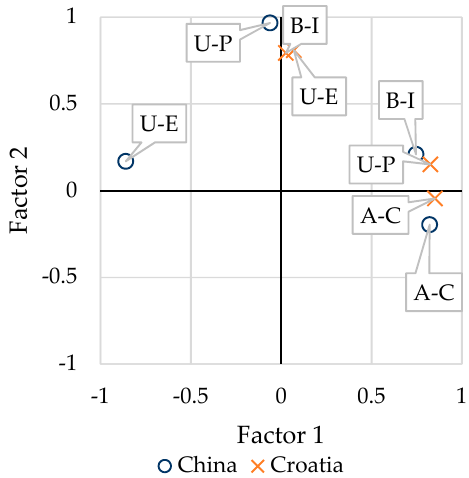
Figure 1. Sound satisfaction of public open Figure 2. Environmental satisfaction of Figure 2. Environmental satisfaction of public open spaces in China and Croatia. spaces in China and Croatia. public open spaces in China and Croatia.